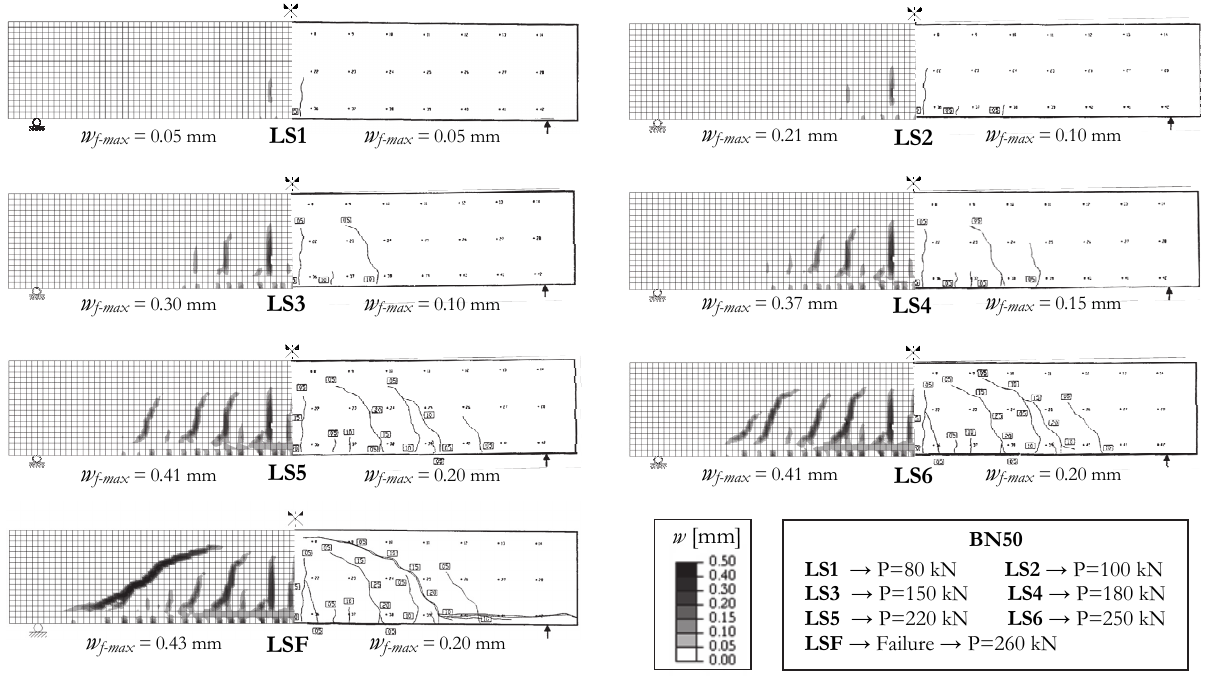
Figure 6: Numerical (left side) vs. experimental (right side, [18]) crack patterns and crack widths at different loading stages for specimen